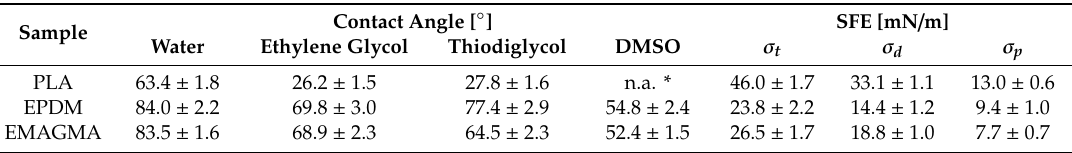
Table 2. Contact Angles and Calculated Surface Free Energy (SFE) of Poly(lactic acid) (PLA), Ethylene-Propylene-Diene-Rubber (EPDM) and poly(Ethylene-Co-Methyl Acrylate-Co-Glycidyl Methacrylate) (EMAGMA).